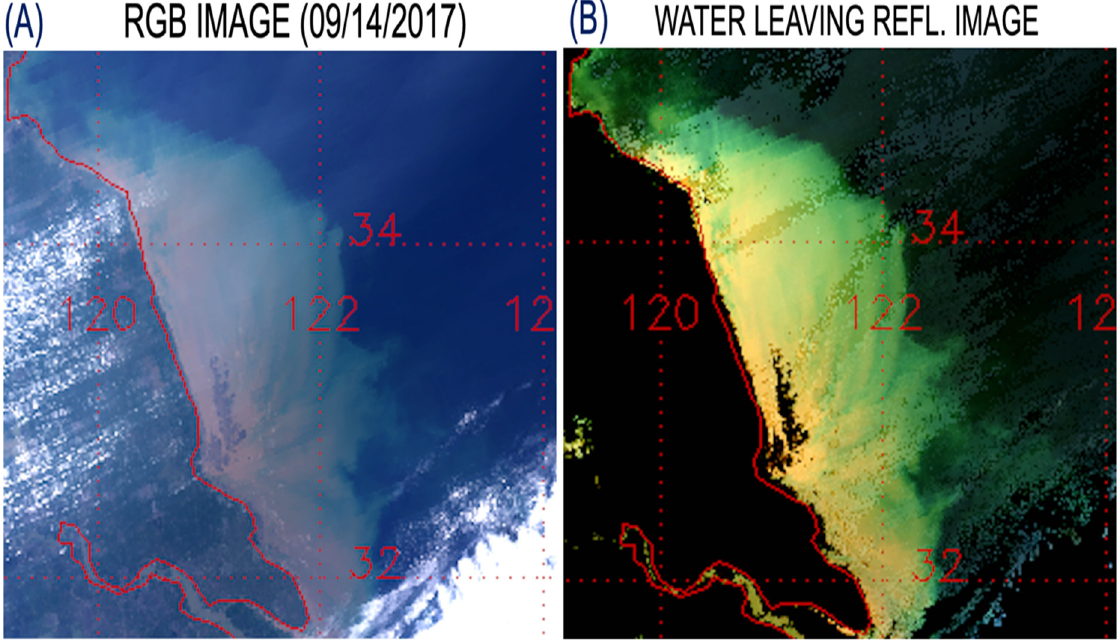
Figure 4. ( A )—a portion of VIIRS RGB image acquired over the eastern coastal area of China on 14 September 2017; and ( B )—the retrieved RGB water leaving reflectance image.